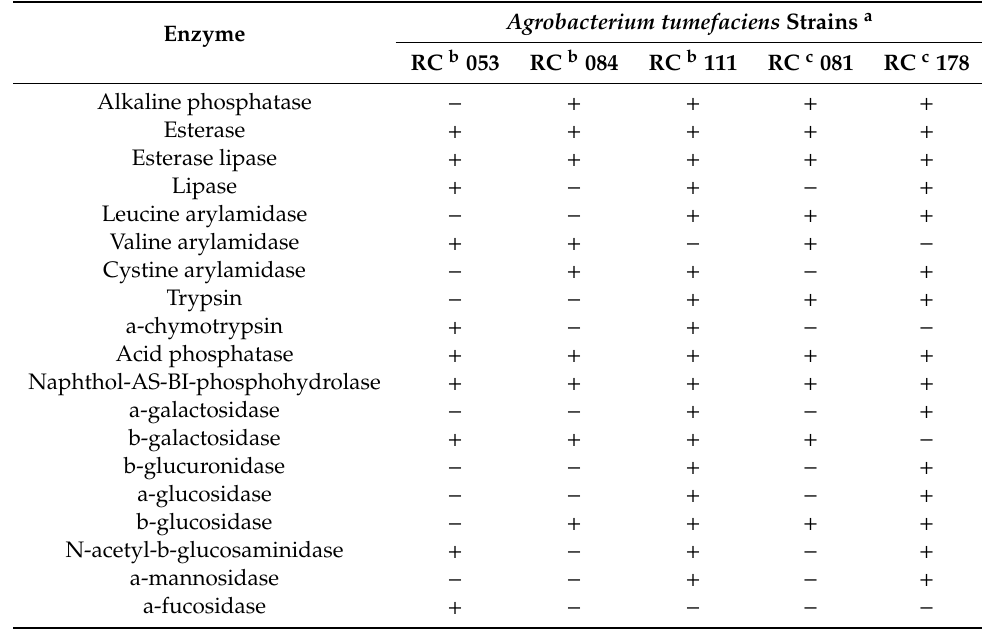
Table 2. Enzymatic activities of avirulent and virulent isolates from crown gall.